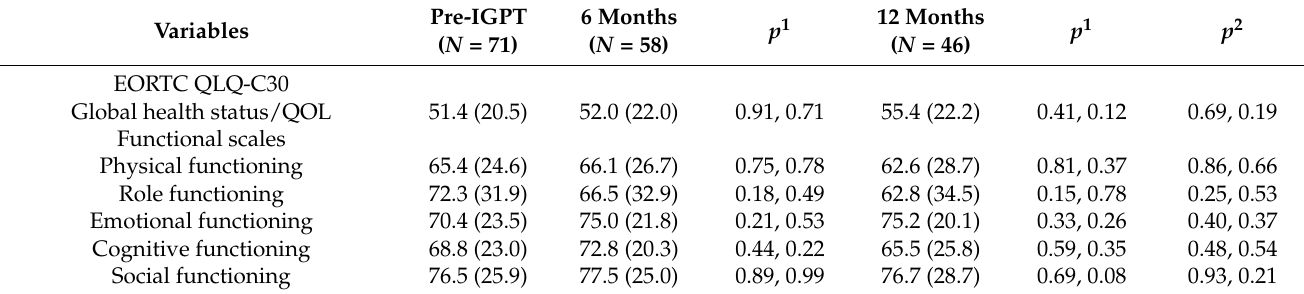
Table 6. Temporal changes in the quality of life score after image-guided proton